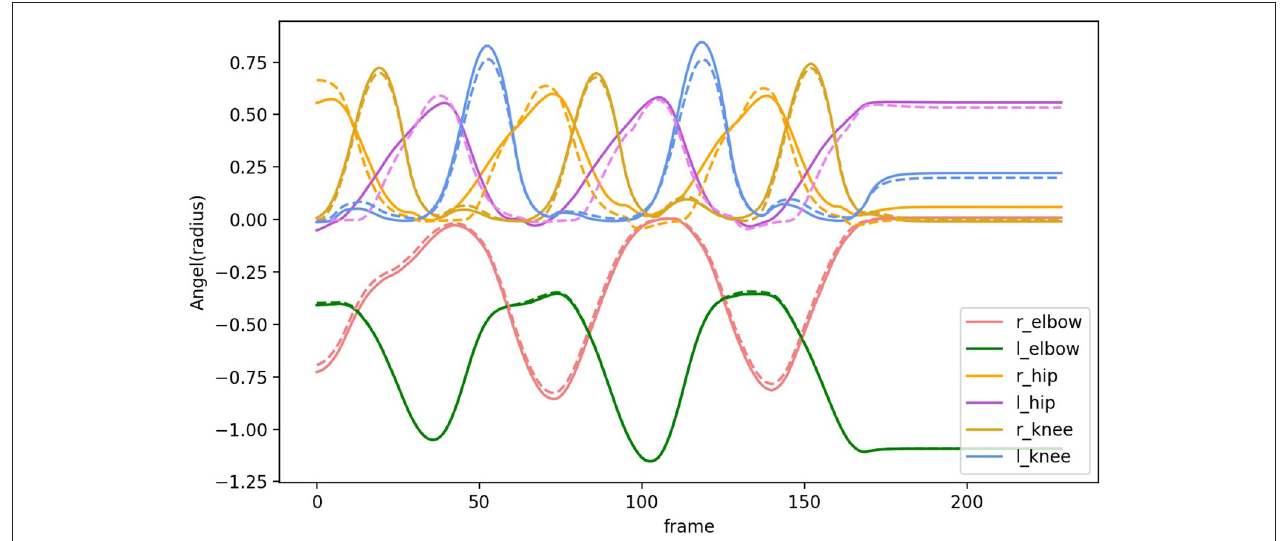
FIGURE 12 | Comparison of joint angles along the selected degree of freedom. Solid lines show joint angles recovered based on the full marker set. Dashed lines show joint angels recovered based on a reduced marker